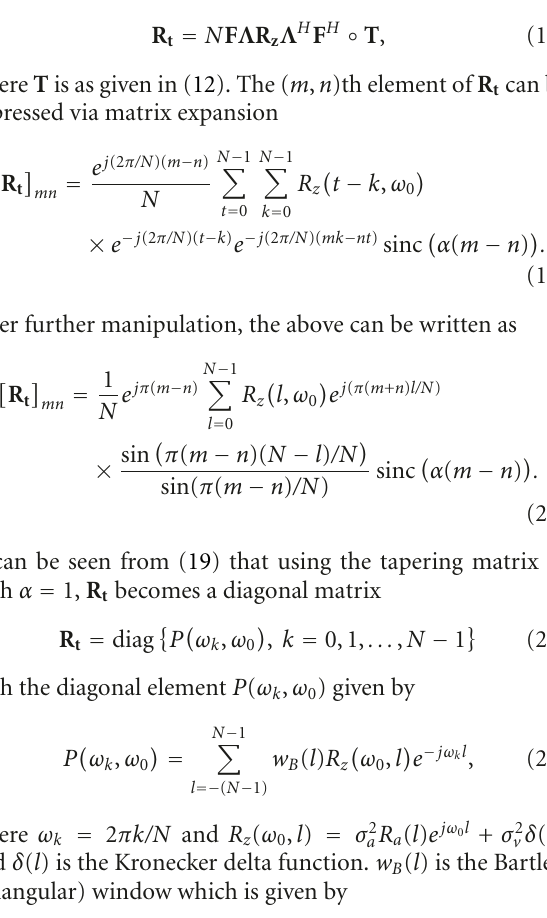
Figure 1: The exact CRB compared with the CRB when CMT reg- ularization is used for di ff erent SNRs, SNR = 25,60,100 and the normalized Doppler frequency f d = 0 . 01, μ =